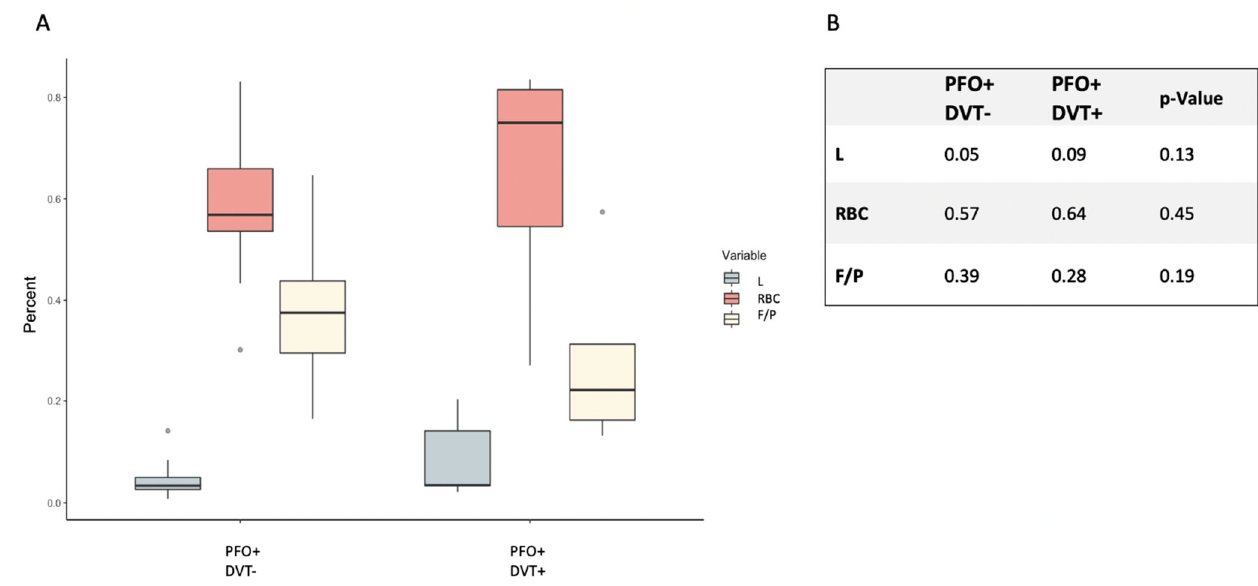
Figure 2. Histological thrombus composition comparing DVT+ and DVT– patients in PFO+ patients. ( A ) Boxplots of thrombus composition comparing subgroup PFO+DVT– and PFO+DVT+. ( B ) Numeric overview comparing mean thrombus composition of the PFO+DVT– and PFO+DVT+ subgroup and its calculated p ‐ value. DVT = Deep vein thrombosis, PFO = patent foramen ovale, L = Leukocytes, RBC = red blood cell count, F/P = Fibrin/Platelets.